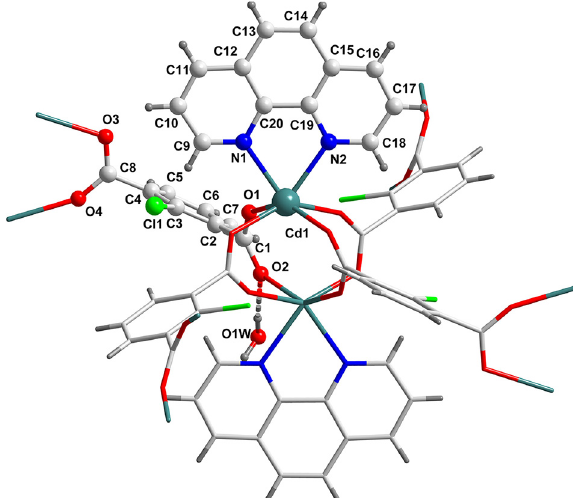
Table 1 contains crystallographic data and Table 2 contains the list of the atoms including atomic coordinates and displacement parameters.